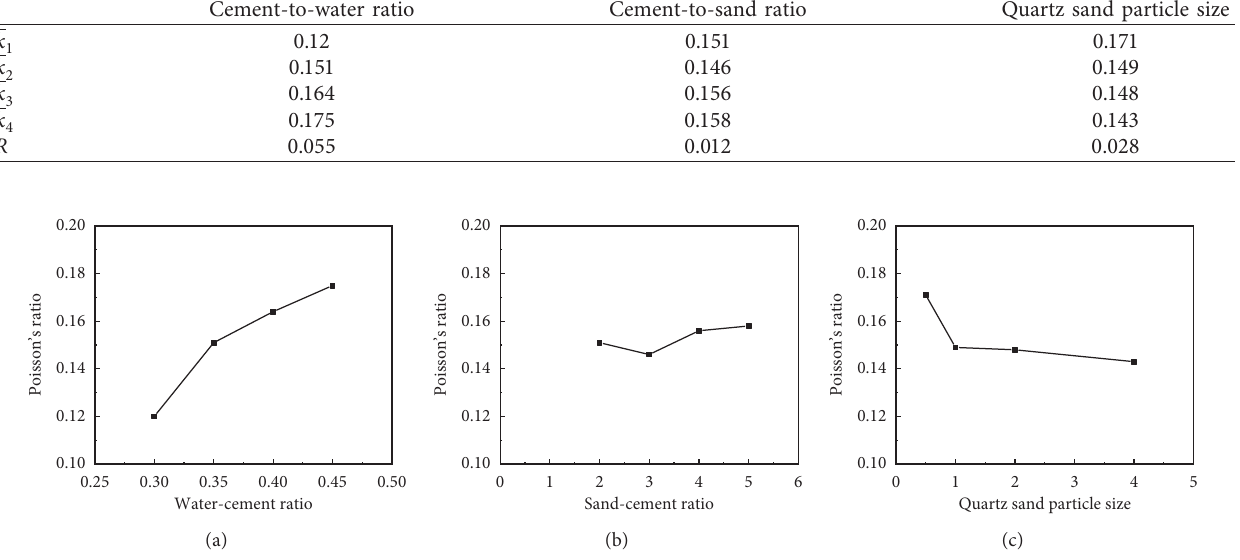
Figure 6: Sensitivity factor analysis of Poisson’s ratio.